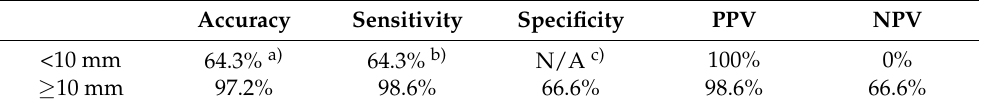
Table 5. Diagnostic histological results of